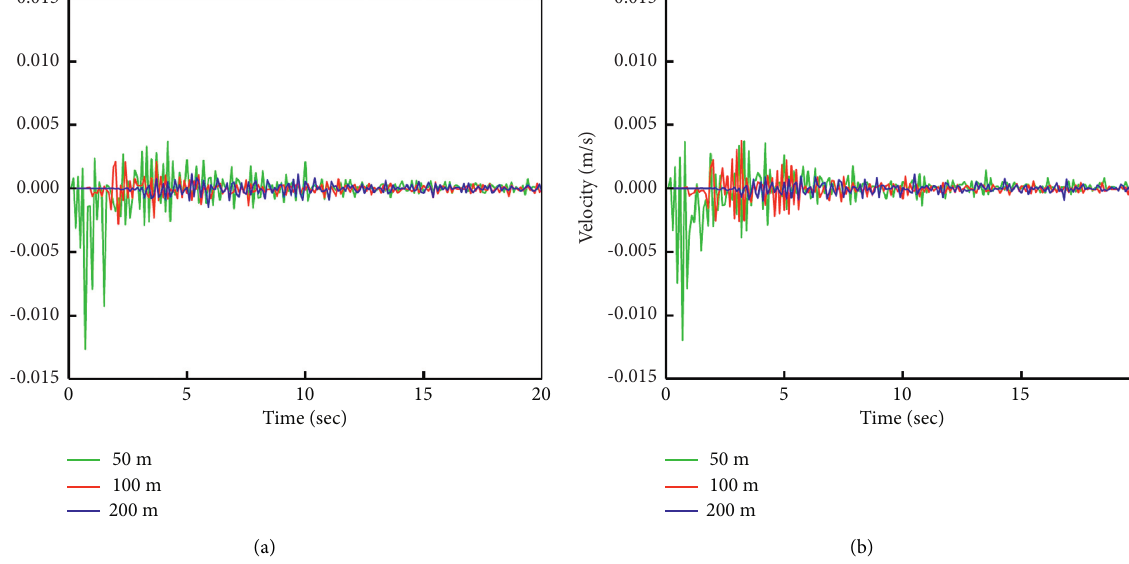
Figure 18: Comparison of the vertical vibration velocity histories for different combinations: (a) linear arrangement and (b) quincuncial